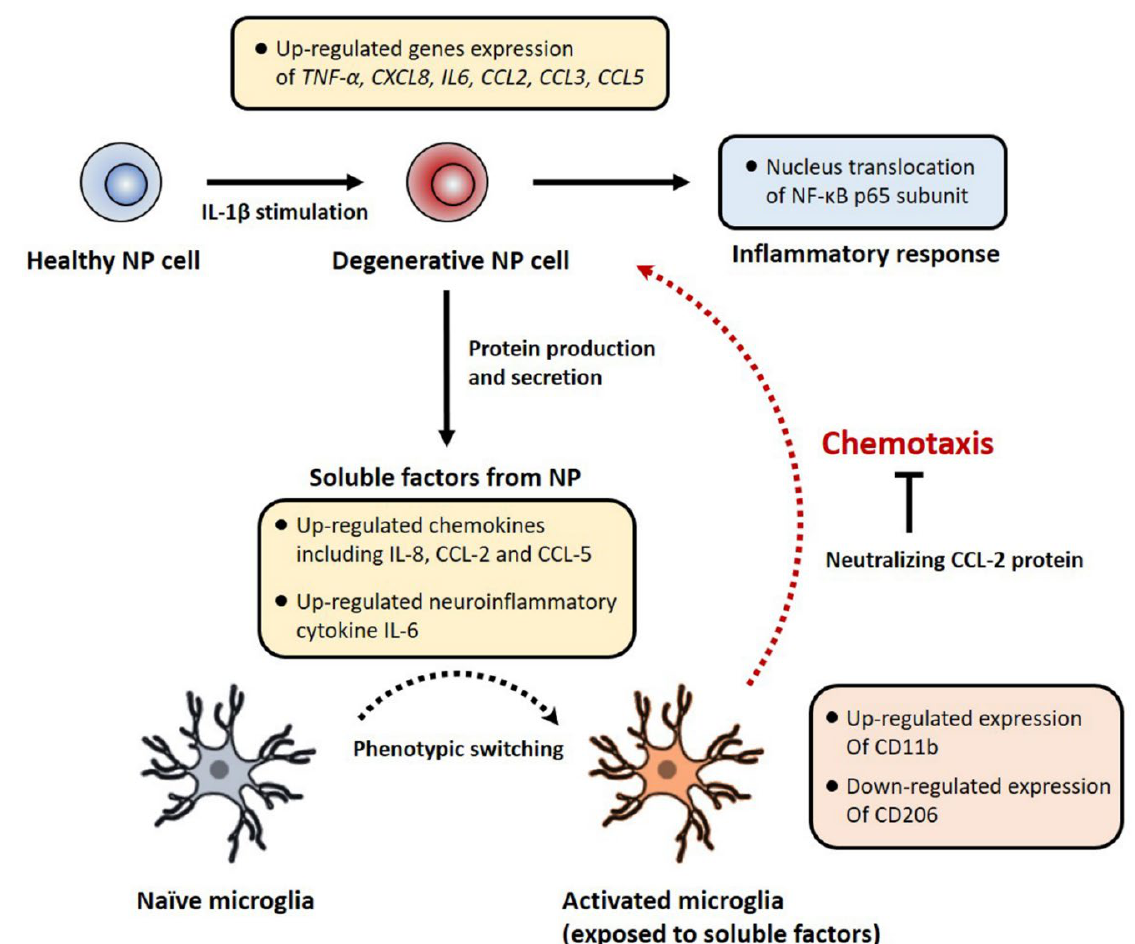
Figure 6. A schematic summary of the degenerative NP in vitro model and the effects of soluble factors derived from human NP cells on microglia’s chemotaxis and activation. In this study, IL-1 β stimulation activates the NF- κ B signaling pathway on human NP cells, which controls the expression of inflammatory and chemotactic genes encoding including TNF- α , IL6, CXCL8, CCL2, CCL3 and CCL5 via nucleus translocation of NF- κ B p65 subunit. IL-1 β -stimulated human NP cells show the protein production of IL-6, IL-8, CCL-2, and CCL-5. Conditioned medium containing these factors induces the recruitment and activation of microglia. Furthermore, neutralizing CCL-2 inhibits this chemotaxis effect in our microfluidic platform. Together, this pathomechanism can provide novel therapeutic target molecules for microglia-mediated neuroinflammation with LBP in IVD